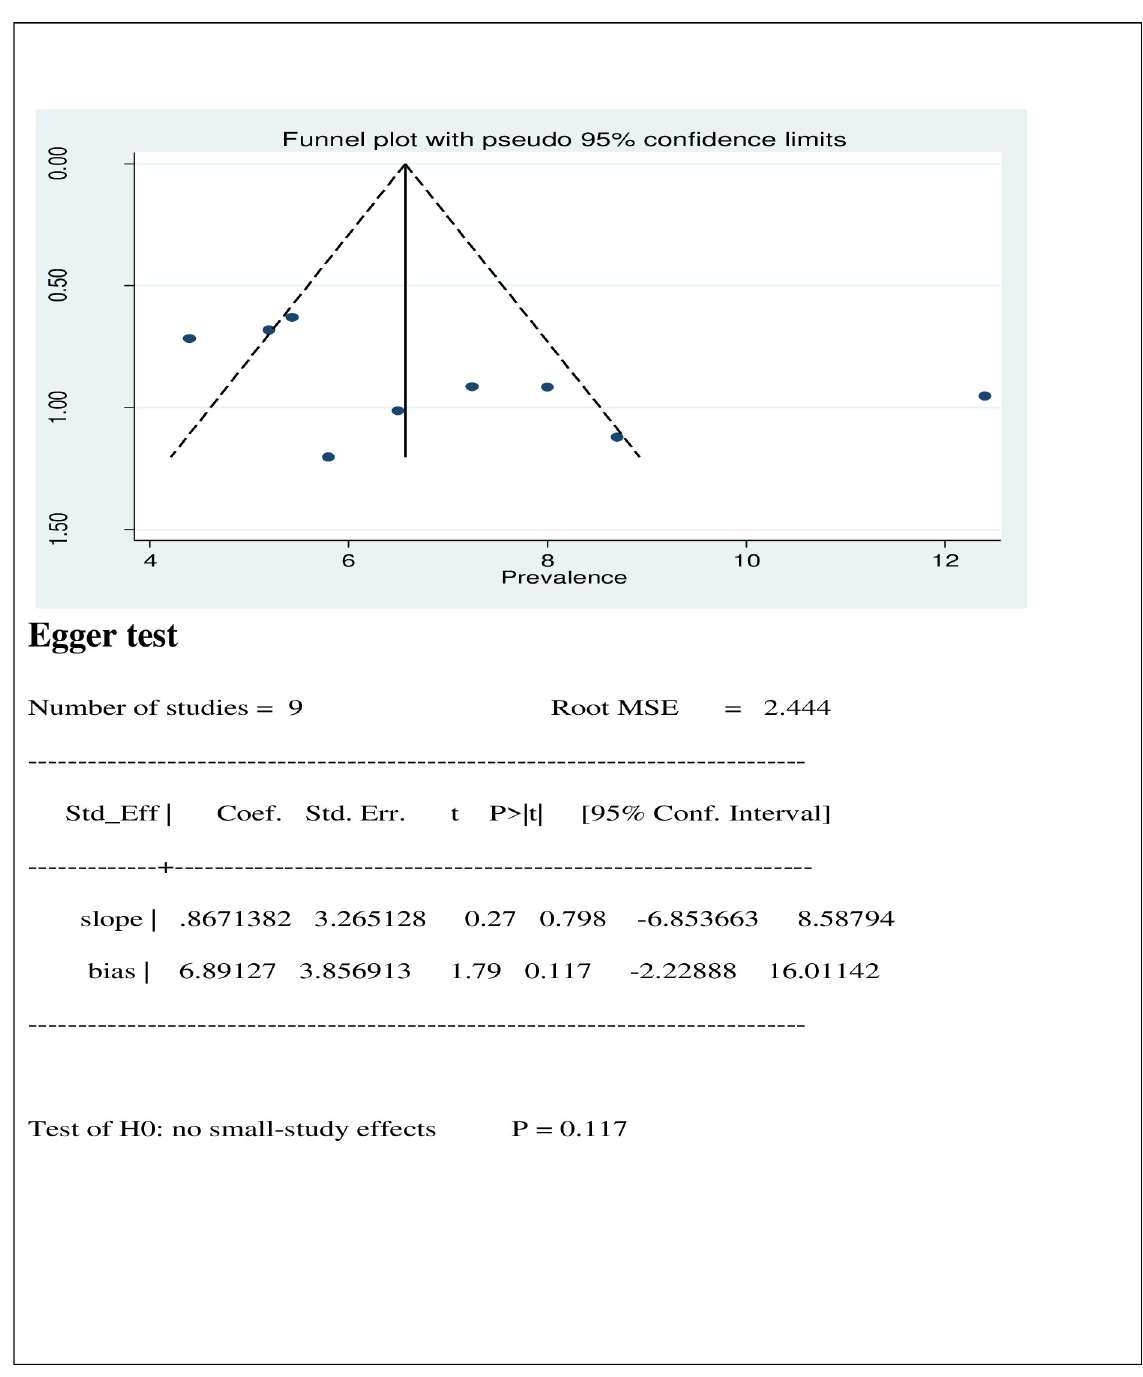
Fig 5. Funnel plot and egger test of the 9 studies include in meta-analysis of visual impairment among children in Ethiopia,